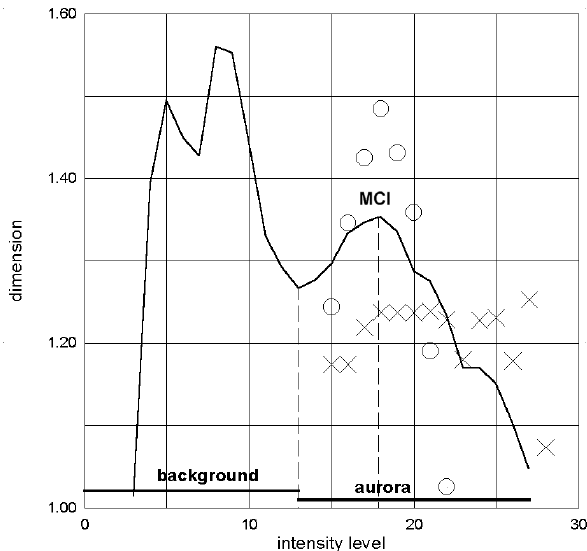
Fig. 1. Box-counting dimension of isoline as a function of intensity level: solid line – for full image; crosses – for linear arc; circles – for diffuse